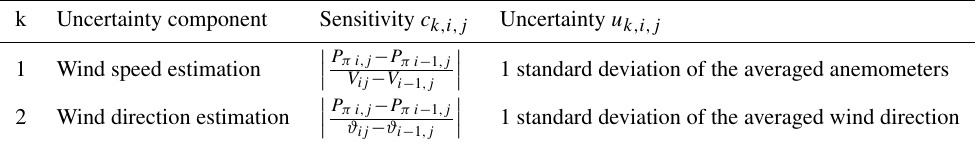
Table 1. Type B uncertainties of the predicted power P π .